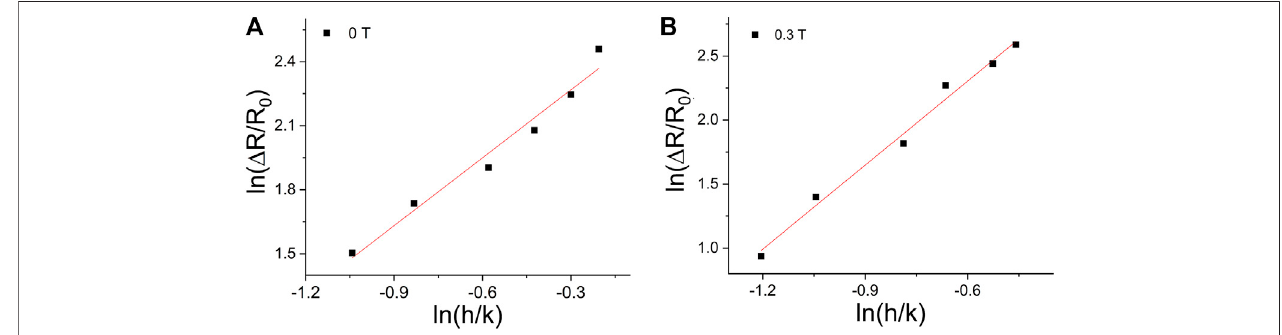
FIGURE 6 | The peak values of Δ R / R 0 with different drop height in the absence (A) and presence (B) of the magnetic fi eld. The lines showed fi tting results.